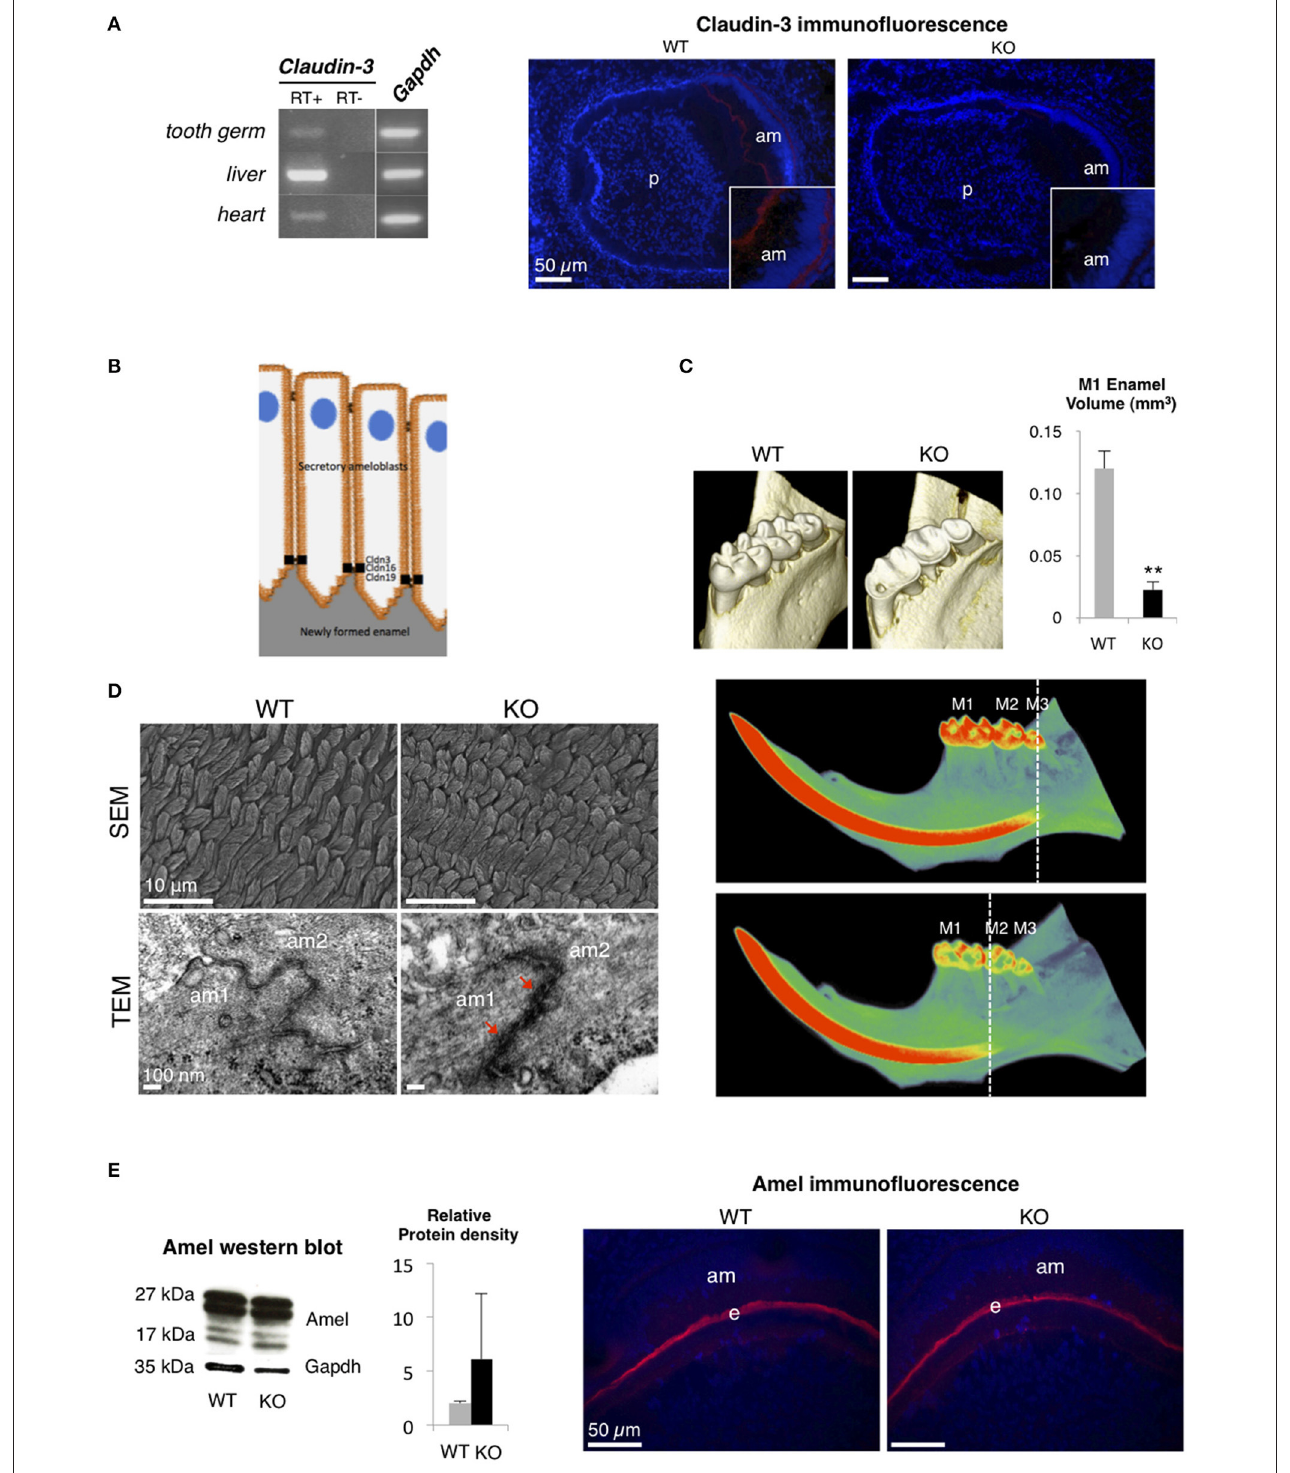
FIGURE 1 | Dental phenotype of Claudin-3 KO mice. (A) Claudin-3 mRNA expression was analyzed in mouse tissues by RT-PCR using forward primer 5 ′ -ATG TGG CGC GTT TCG-3 ′ and reverse primer 5 ′ -GCG AGT CGT ACA TTT TGC-3 ′ for Claudin-3 (124 bp), and forward primer 5 ′ -TGT GTC CGT CGT GGA TCT GA-3 ′ and reverse primer 5 ′ -TTG CTG TTG AAG TCG CAG GAG-3 ′ for Gapdh (150 bp). A representative gel image of the selected tissues showed Claudin-3 expression in